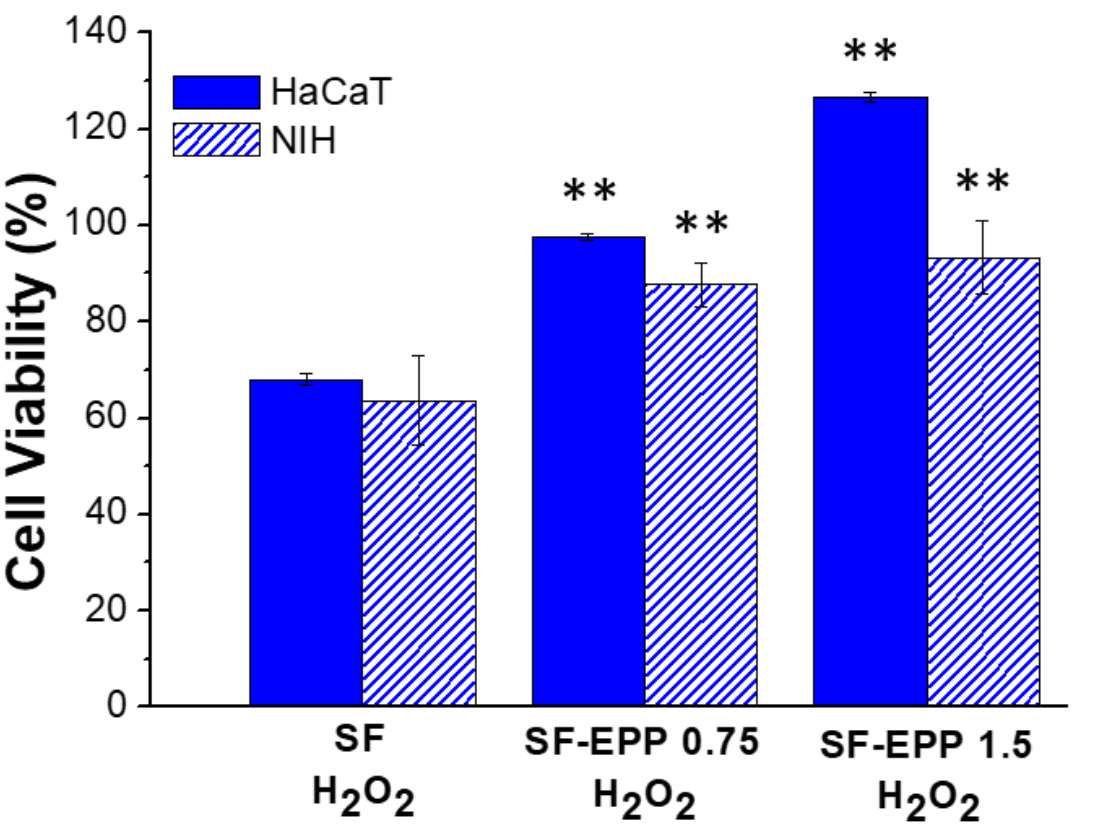
Figure 9. MTT test carried out after 48 h of incubation on HaCaT and NIH cells plated on SF and SF-EPP films and treated with H 2 O 2 . Data represent mean ± standard deviation. Statistical analyses were performed using ANOVA followed by Tukey’s test. ** p < 0.01, denote significant differences with respect to the control.